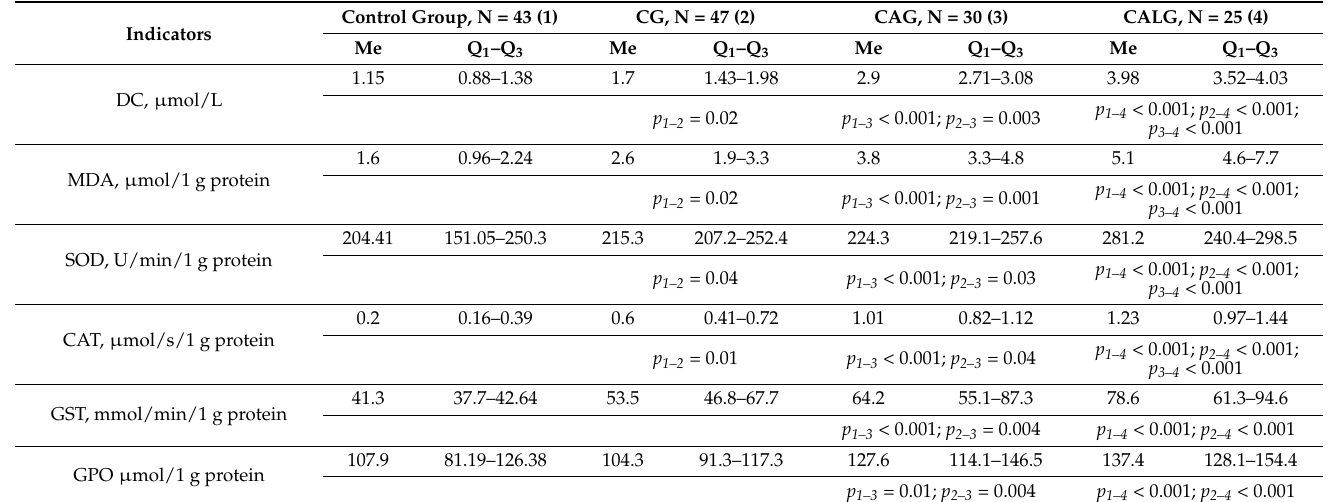
Table 6. Characterization of indicators of the LPO–AOD system in various types of chronic gastritis with a serum response against H. pylori in the form of an increase in